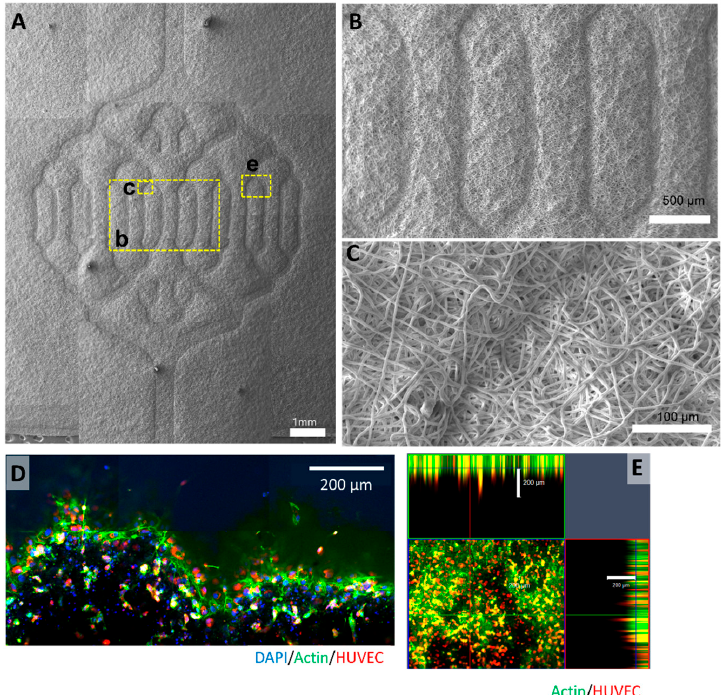
Figure 2. Embossed polycaprolactone (PCL) membrane. ( A ) SEM imaging shows embossed pattern of vacuum-formed electrospun PCL membrane. ( B , C ) Further magnification of formed PCL embossed membrane shows detail of embossing and woven electrospun PCL fibers. ( D ) Confocal image and ( E ) orthogonal views of human umbilical vein endothelial cells (HUVECs) on embossed PCL membrane on day three. Scale bars are 200 µm. Green: F-Actin, red: HUVEC, blue: DAPI.